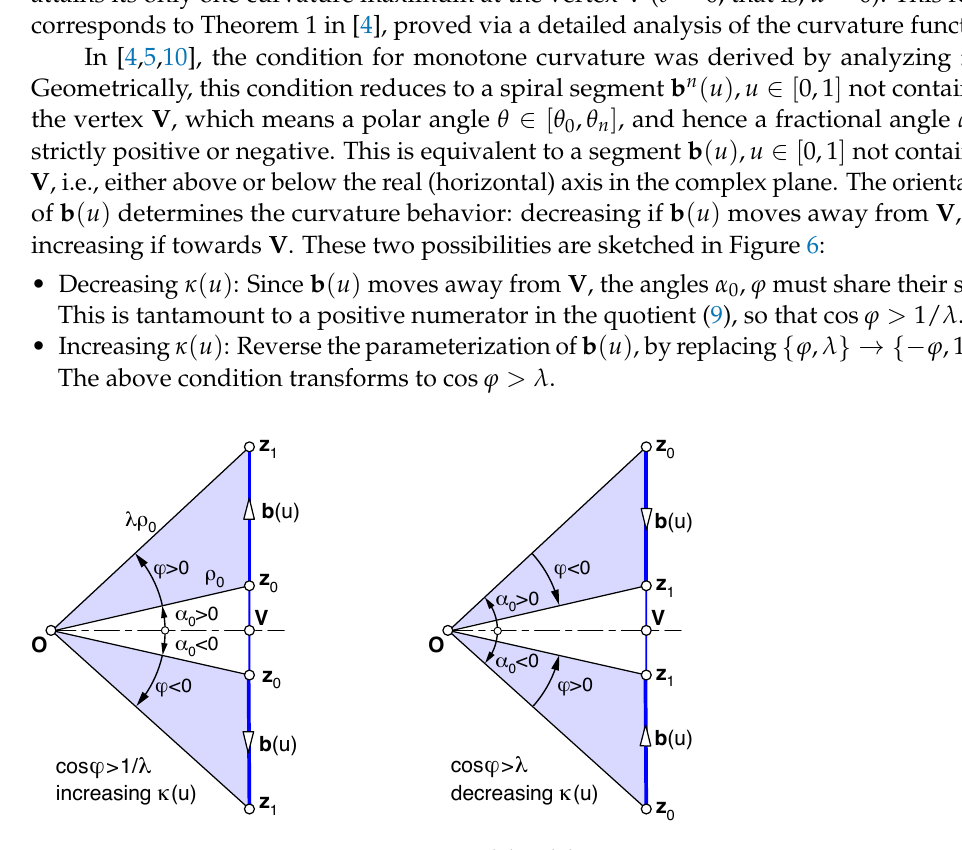
Figure 6. Condition for monotone curvature κ ( u ) : b ( u ) must not contain the vertex V